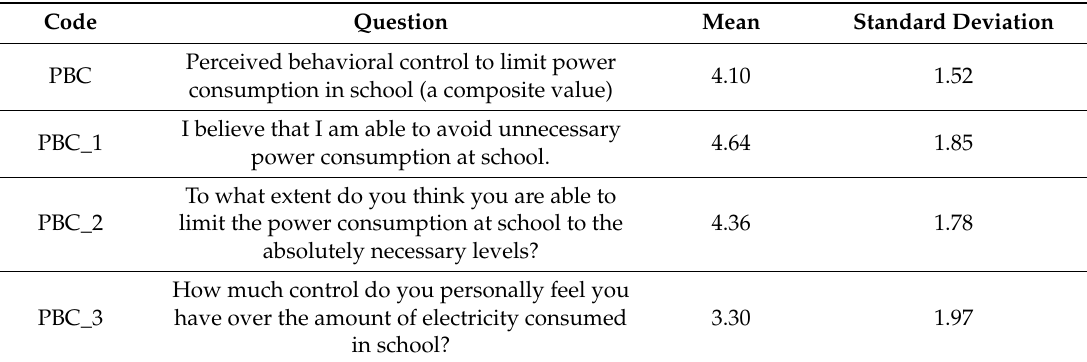
Table 12. Mean for perceived behavioral control (not at all able to do it (1) to able to do it to a high extent (7) / very little control (1) to complete control (7)).